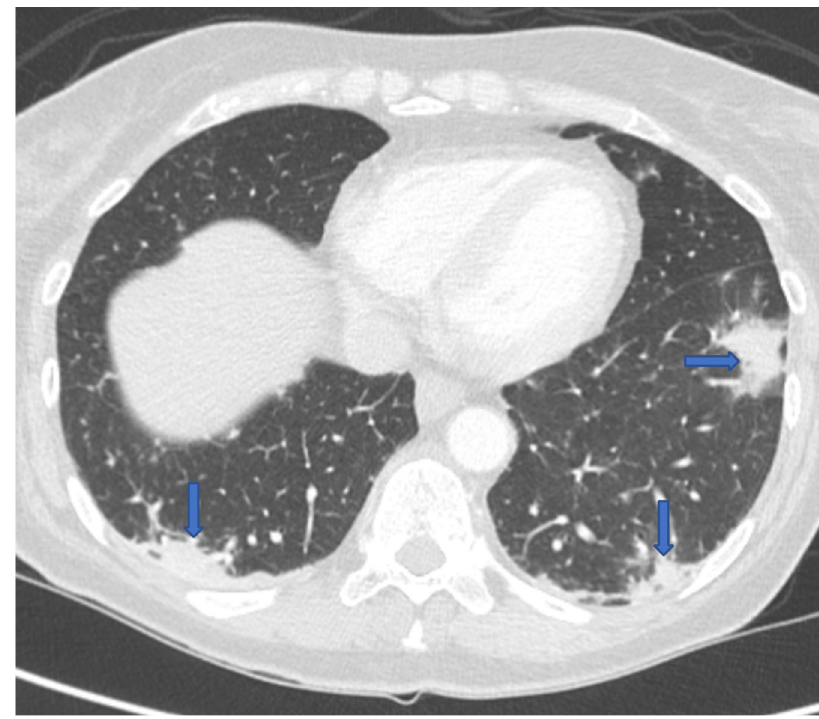
Figure 1. CT chest revealing multifocal bilateral peripheral